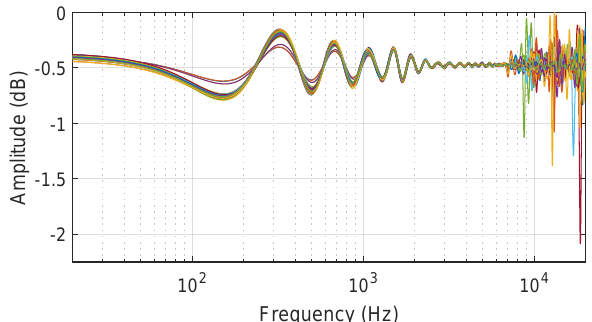
Figure 6. The final normalised diffuse field response of each ear of each subject (total 40 responses) after all post-processing.